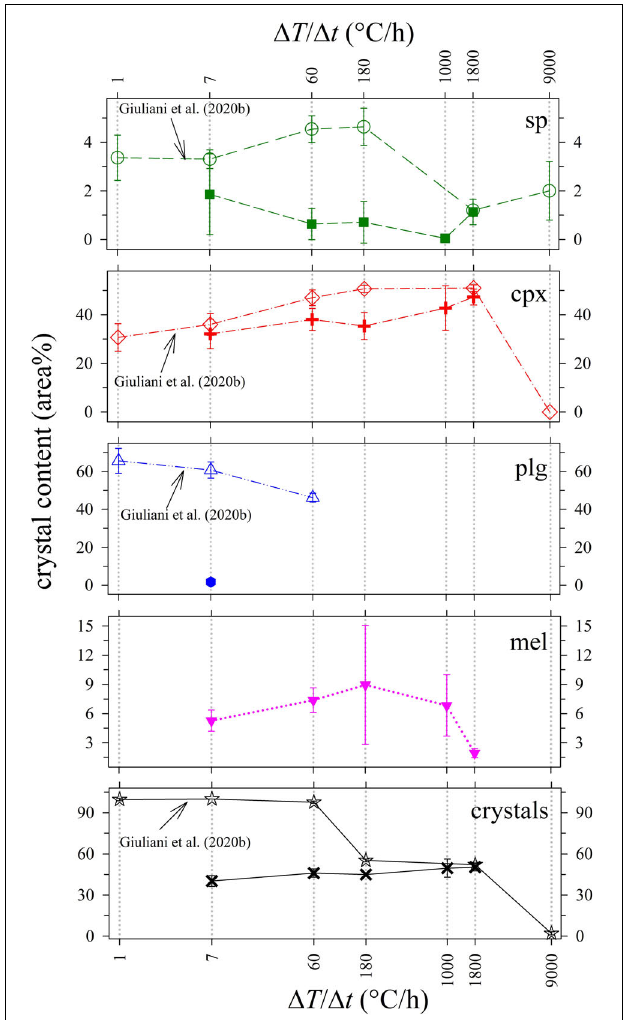
FIGURE 4 | Crystal content (area%) vs (cid:49) T / (cid:49) t ( ◦ C/h) of in situ DSC experiments compared with ex situ cooling rate experiments from Giuliani et al. (2020b).